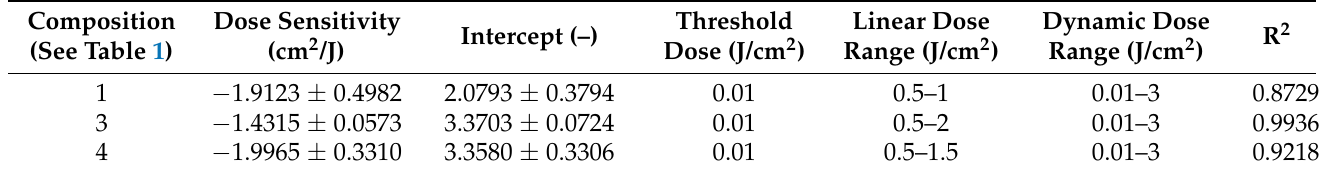
Figure 2. The absorbance spectra of TBO ‒ Pluronic F ‒ 127 dosimeter containing different concentrations of TBO and H 2 O 2 : composition 1 ( a ), 3 ( b ) and 4 ( c ) (see Table 1) irradiated with UVB radiation in the dose range of 0–3 J/cm 2 and the dose–response of these compositions at a specific wavelength ( d ). Table 2. Basic parameters of TBO ‒ Pluronic F ‒ 127 dosimeters irradiated with UVB radiation.